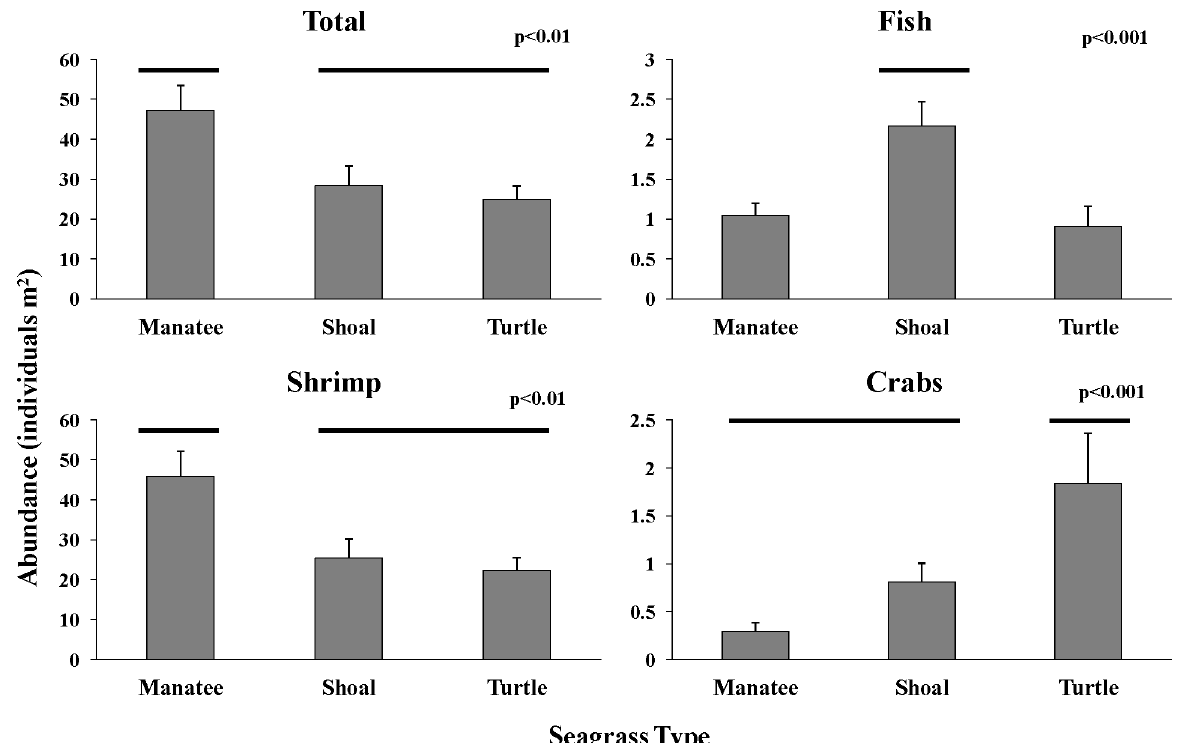
Figure 5. Mean ( + SE) abundance of organisms collected among 3 seagrass species.